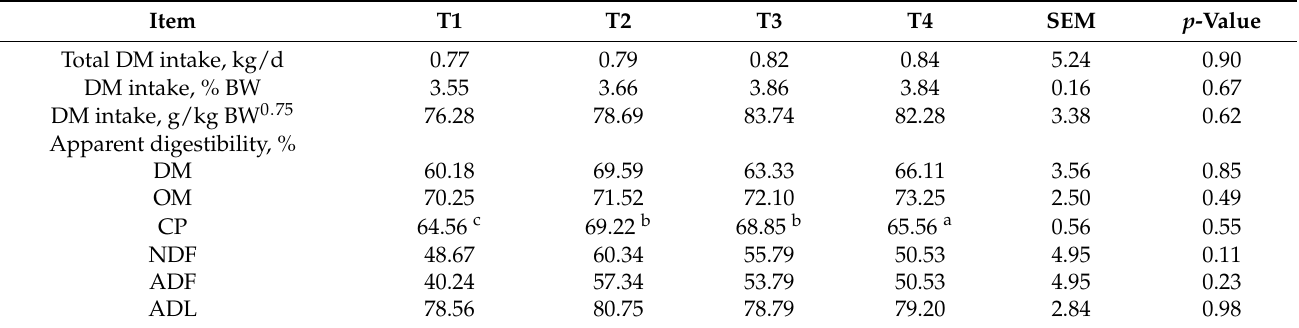
Table 2. The total dry matter intake and apparent digestibility of Thai native sheep fed fermented sugarcane bagasse with or without additives as roughage